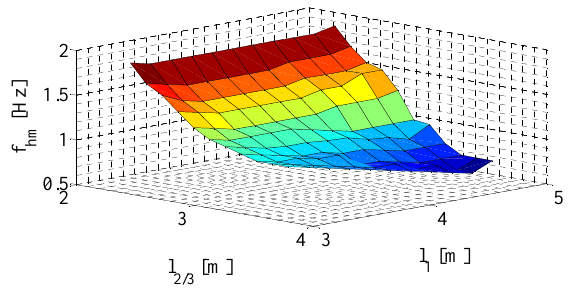
Figure 7: Variation of natural frequency of the crane.